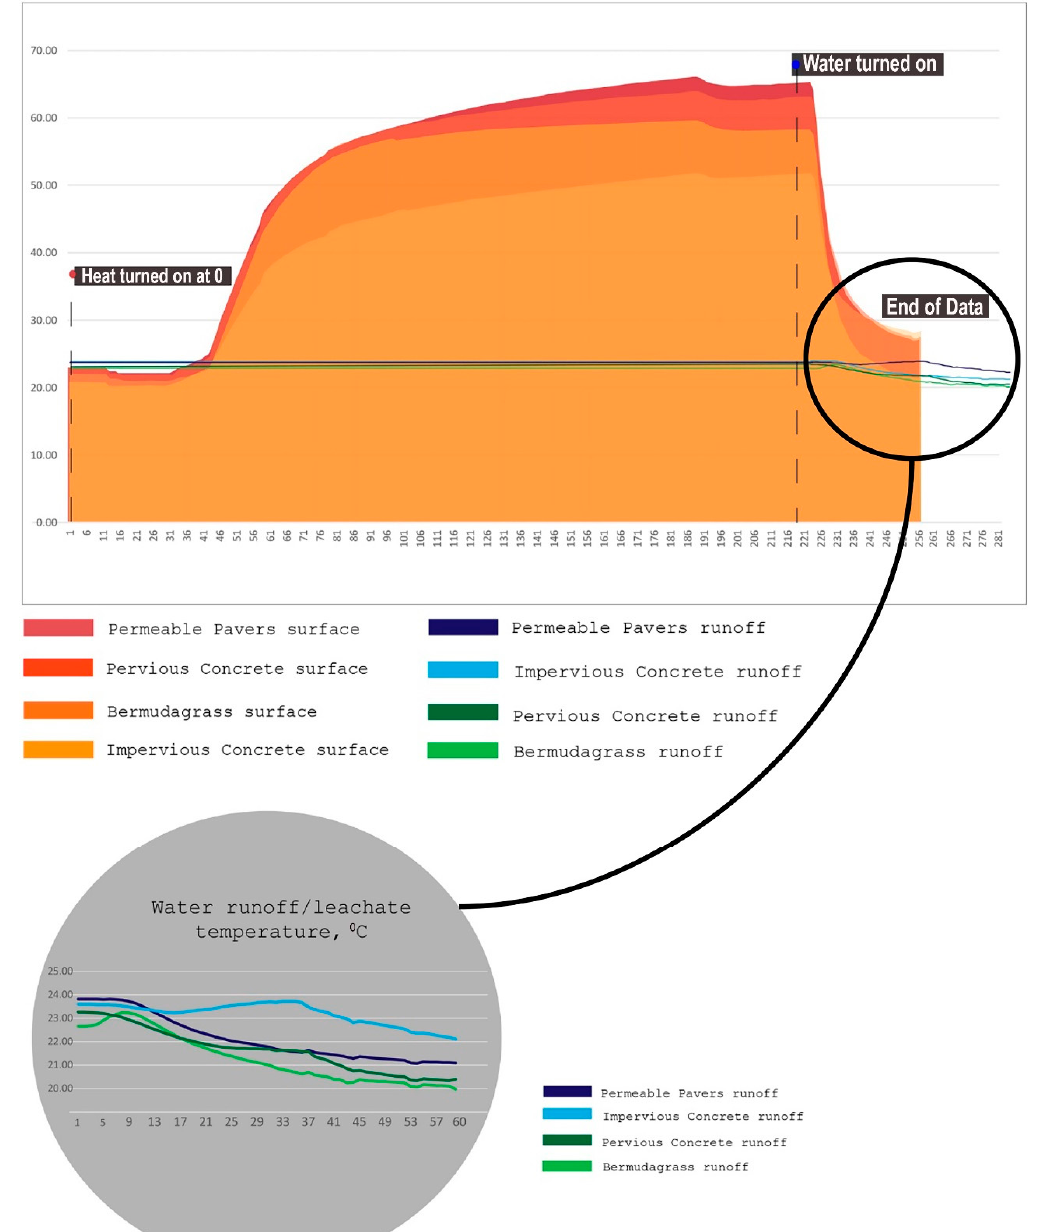
Figure 6. Change in surface temperature °C for selected surfaces in a laboratory study. Bottom bubble highlights the impact on the water temperature immediately after simulated rainfall.